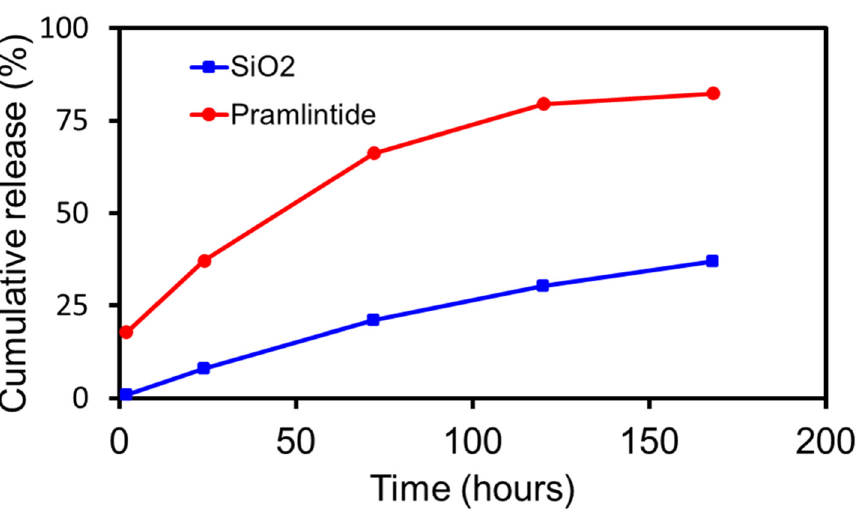
Figure 4. Cumulative estimates of in vitro silica degradation and release of pramlintide from pramlintide-silica depot. Silica dissolution was carried out in 50 mM TRIS–buffer (pH 7.4) and pramlintide release was carried out in PBS (pH 7.4) containing 0.01% Tween 80. Both the studies were carried out at 37 °C under in sink conditions. Data represented as mean for n = 3. SD of each data point was less than 2.5%.